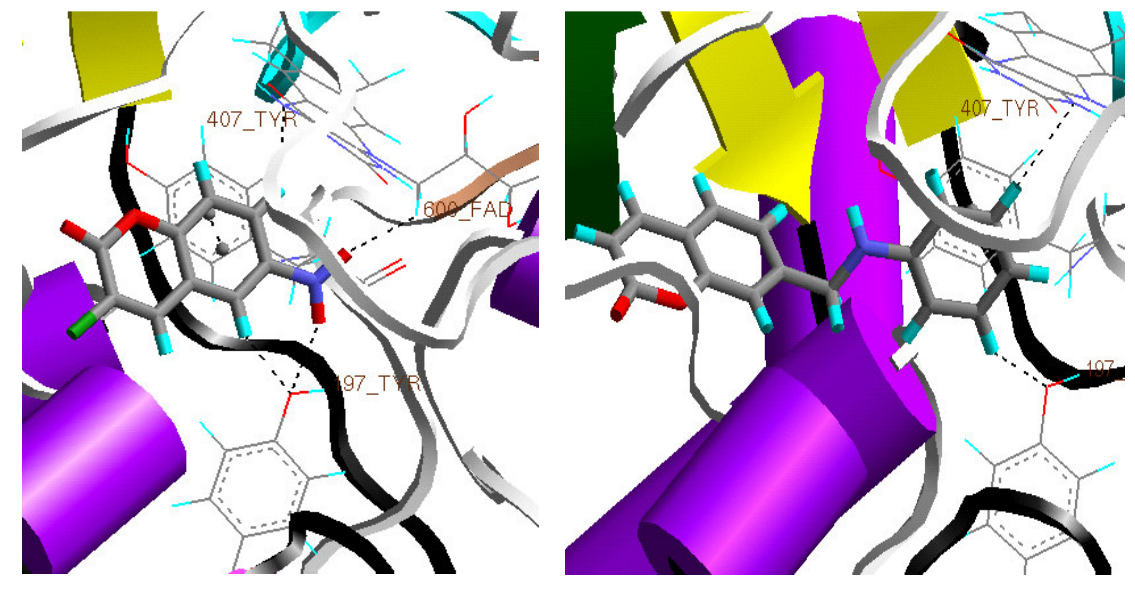
Figure 3: Left figure shows the one of the highest active molecule 64 and interactions with active site amino acids, while figure on the right side shows one of the lowest active molecule 4 in the monoamine oxidase-A active site and fewer weak hydrogen bond interactions with Tyr197 and FAD